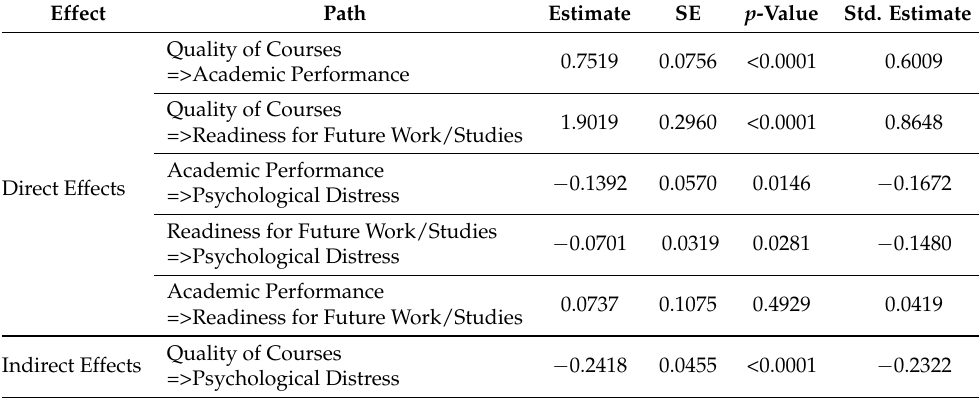
Table 5. SEM path